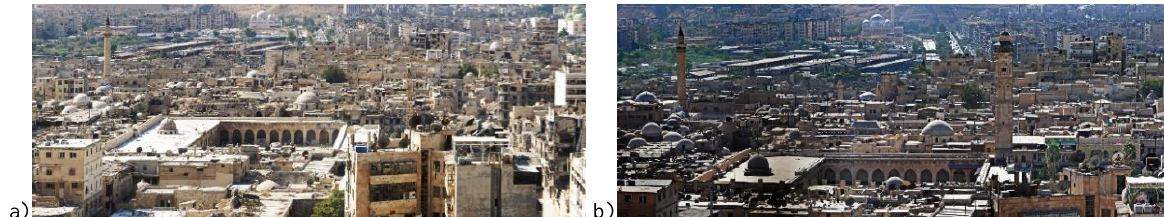
Figure 11: The Omayyadid’s great mosque, current situation (a) and how it was in 2010 (b).